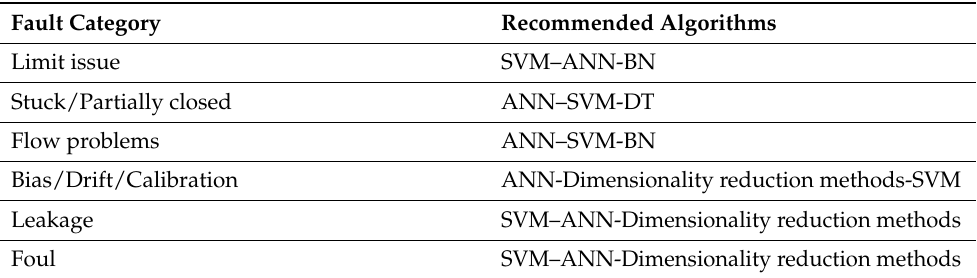
Table 2. Recommend algorithms for an individual category of HVAC systems most common